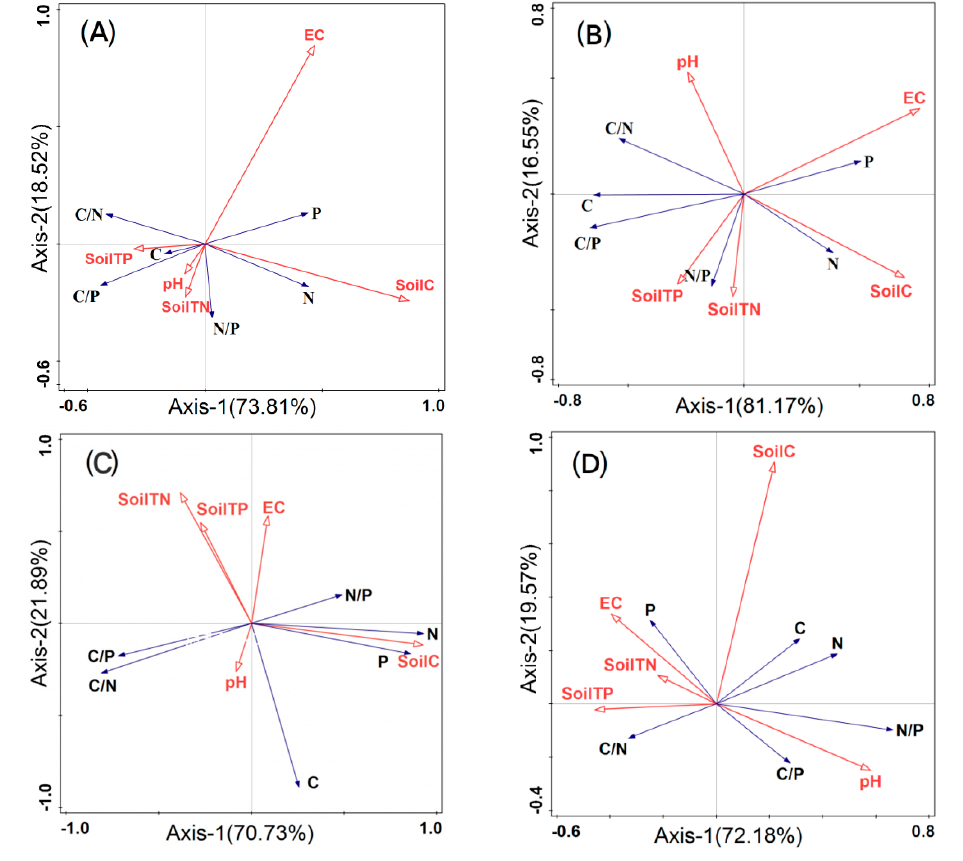
Figure 4. Redundancy analysis two − dimensional ordination diagram of the relationship between leaf C, N, P stoichiometric characteristics and soil factors. Note: (A) whole plants; (B) euhalophytes; (C) pseudohalophytes; (D) secretohalophytes. Table 3. Results of the importance ranking and significance tests of the overall soil factors’ variables interpretation.